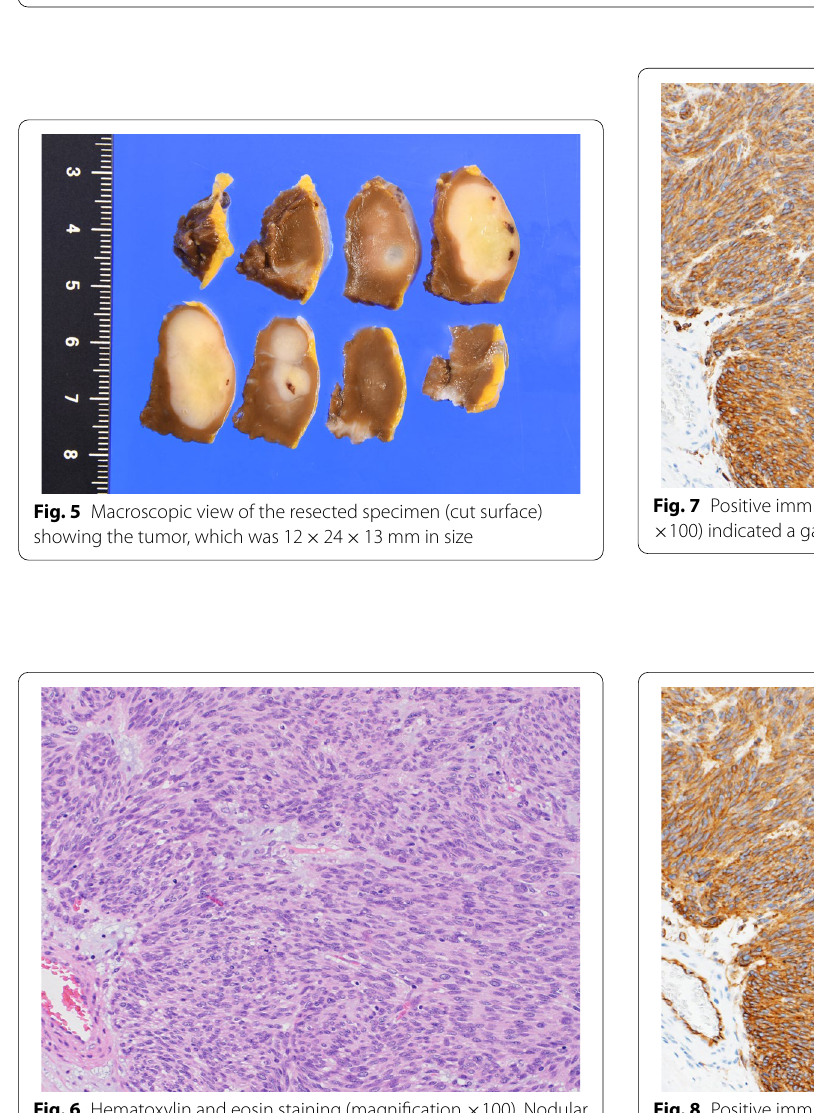
Fig. 4 Intraoperative view of the gastrointestinal stromal tumor (GIST) before resection (yellow arrow) ( A ). Intraoperative view showing the heart after tumor resection ( B ) and the heart with closing sutures and felt strips ( C )